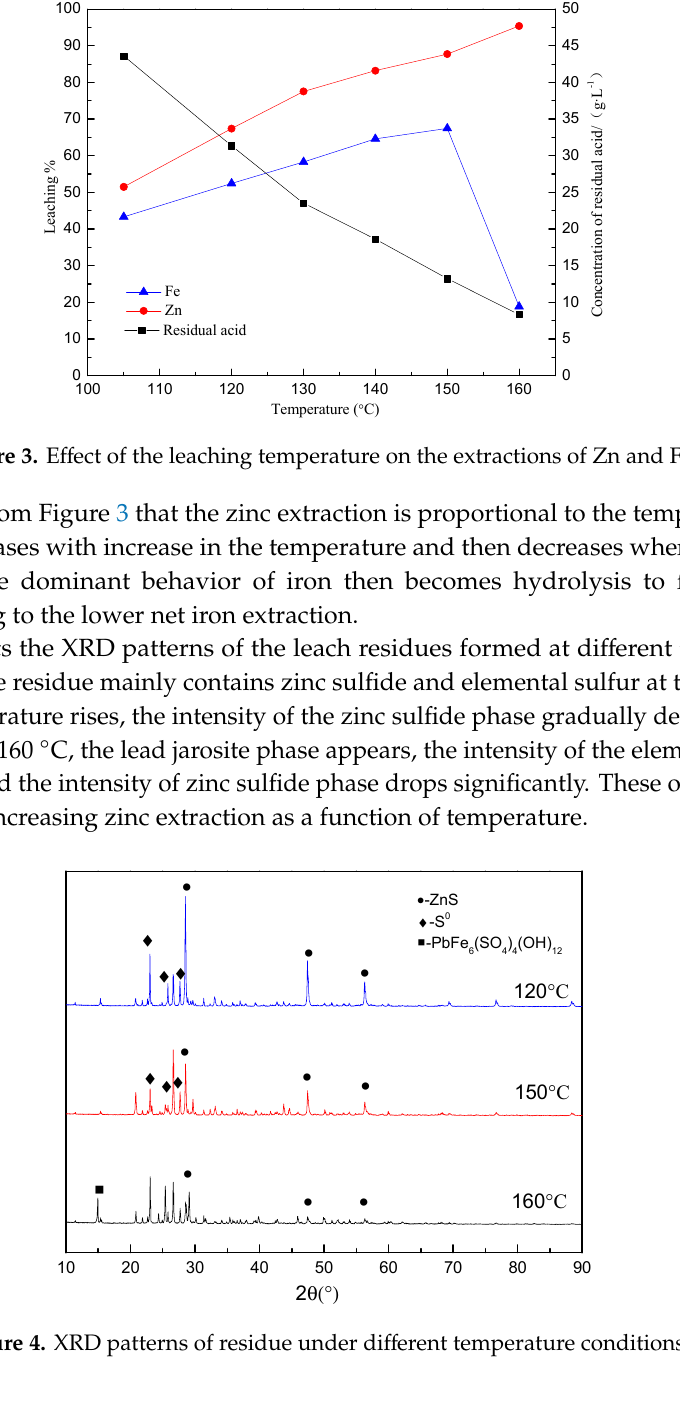
Figure 4. XRD patterns of residue under different temperature conditions.